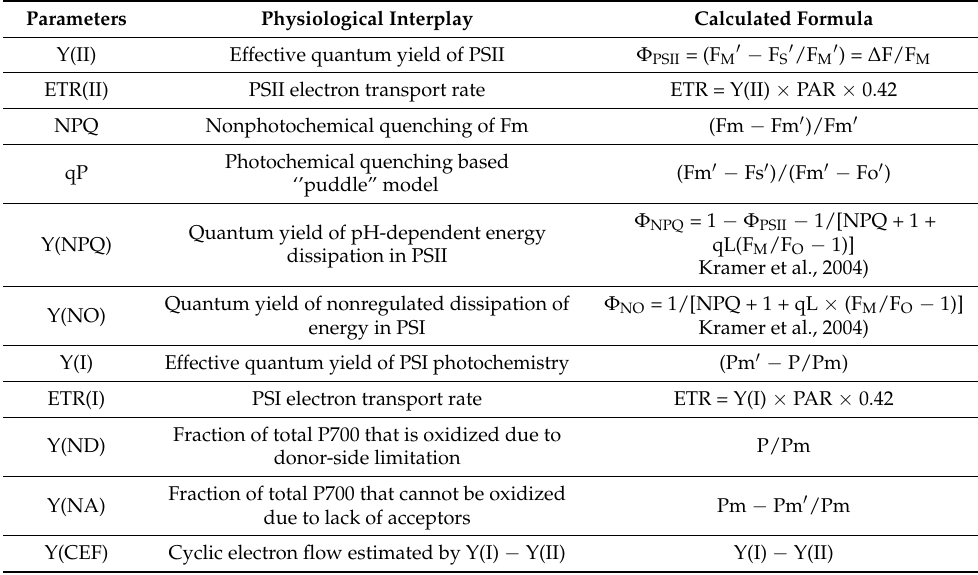
Table 5. Chlorophyll fluorescence measurements using